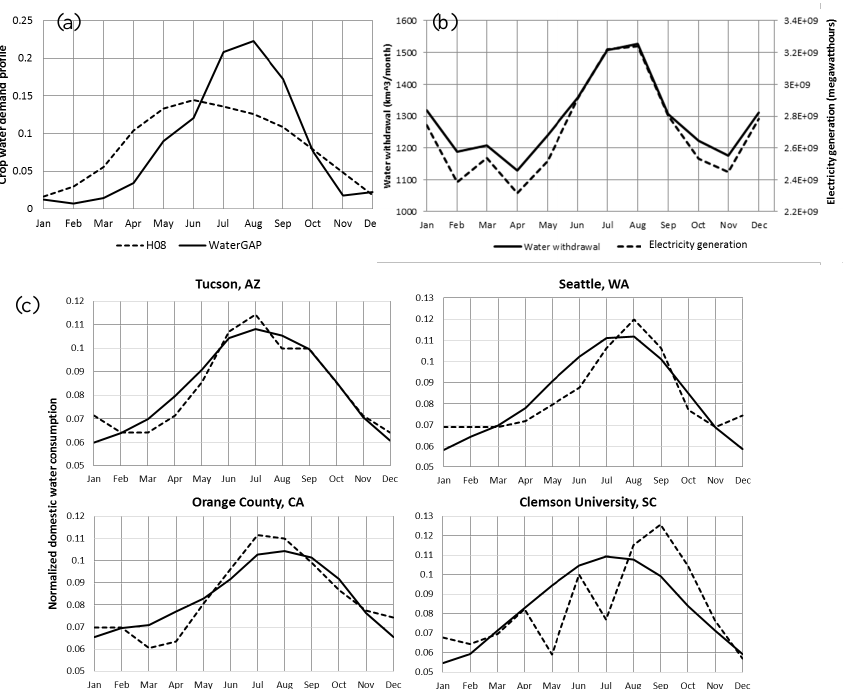
Figure 4: Temporally downscaling GCAM’s annual water demands to monthly profiles: a) irrigation water demand 2 Fig. 4. Temporally downscaling GCAM’s annual water demands to monthly profiles: (a) irrigation water demand profiles averaged over all profiles averaged over all AEZs from two models; b) U.S. monthly water withdrawal for electricity generation for the year 3 AEZs from two models; (b) US monthly water withdrawal for electricity generation for the year 2005; (c) normalized monthly domestic 2005; c) normalized monthly domestic water consumption for Tucson, AZ, Seattle, WA, Orange County, CA and Clemson 4 water consumption for Tucson, AZ, Seattle, WA, Orange County, CA, and Clemson University, SC; the dashed line is calculated based on University, SC; the dashed line is calculated based on reported water consumption and the solid line is calculated from 5 1990 GCAM output using Equation(7). 6 reported water consumption and the solid line is calculated from 1990 GCAM output using Eq.